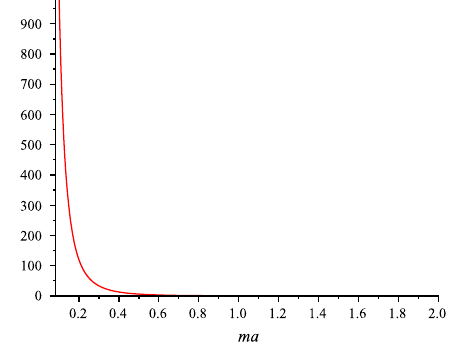
α(cid:9) (cid:9) 3 ,whichgives 1 2 m 3 π